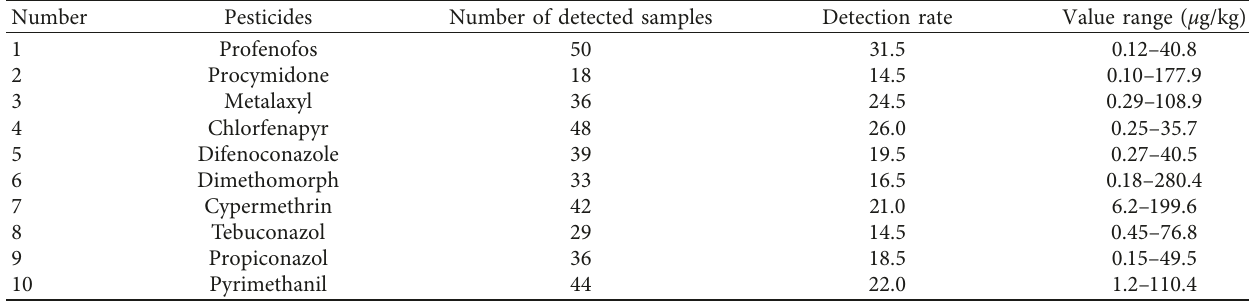
Table 2: Chemical substances with high detection rate detected in chrysanthemum